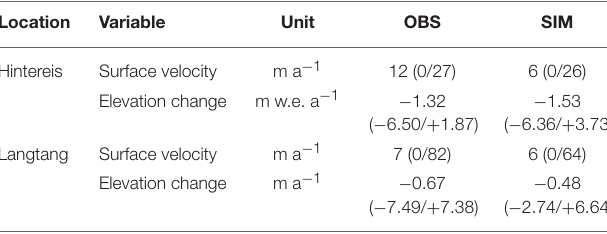
TABLE 3 | Simulated and observed mean surface velocities and elevation changes per glacier tongue.